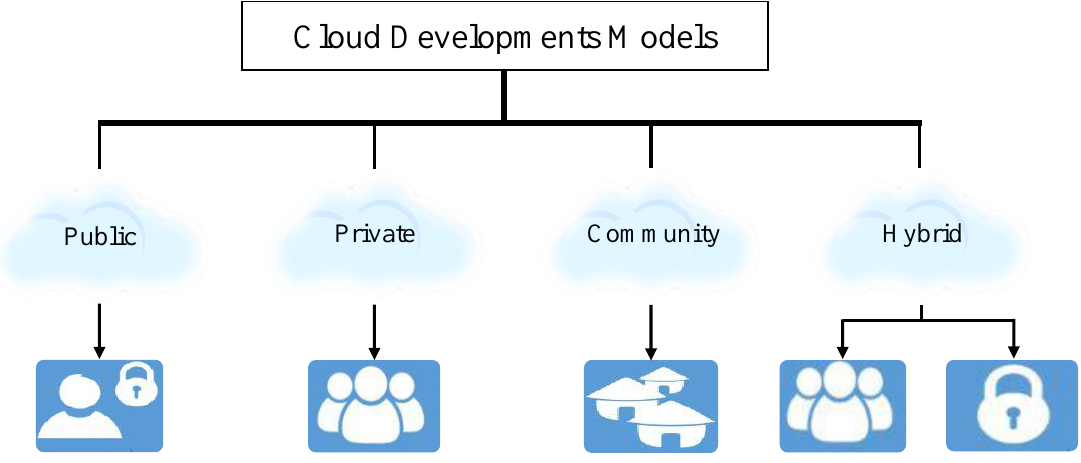
Figure 3. Cloud deployment